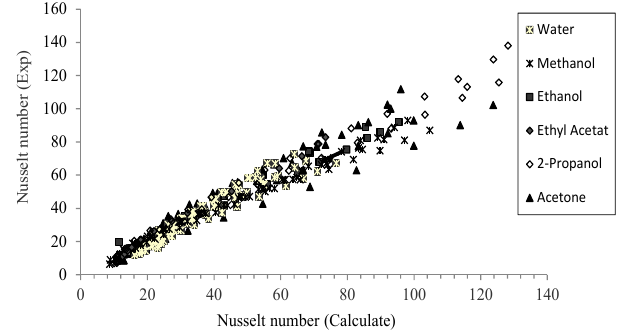
Fig. 5. A comparison of the calculated Nusselt’s dimensionless number for the experimental results and predicted values.